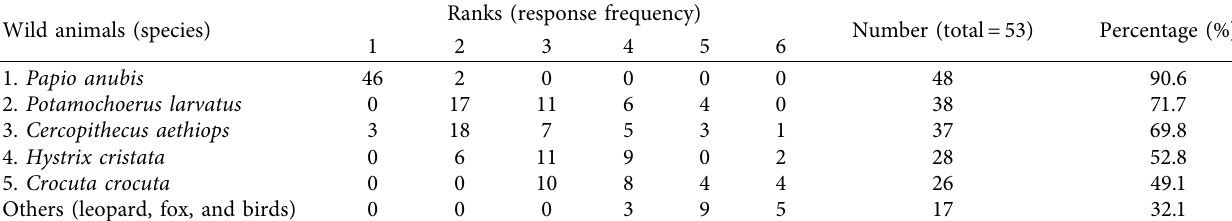
Table 5: Wild animals conflicting with humans in the study